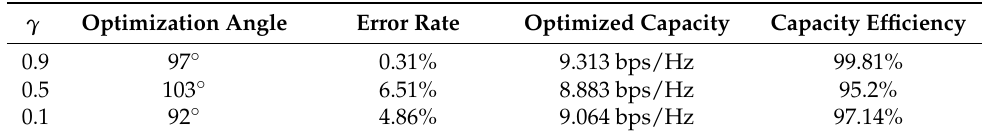
Table 8. Optimized values for antenna downtilt and channel capacity with different discount rates at D = 200 m.